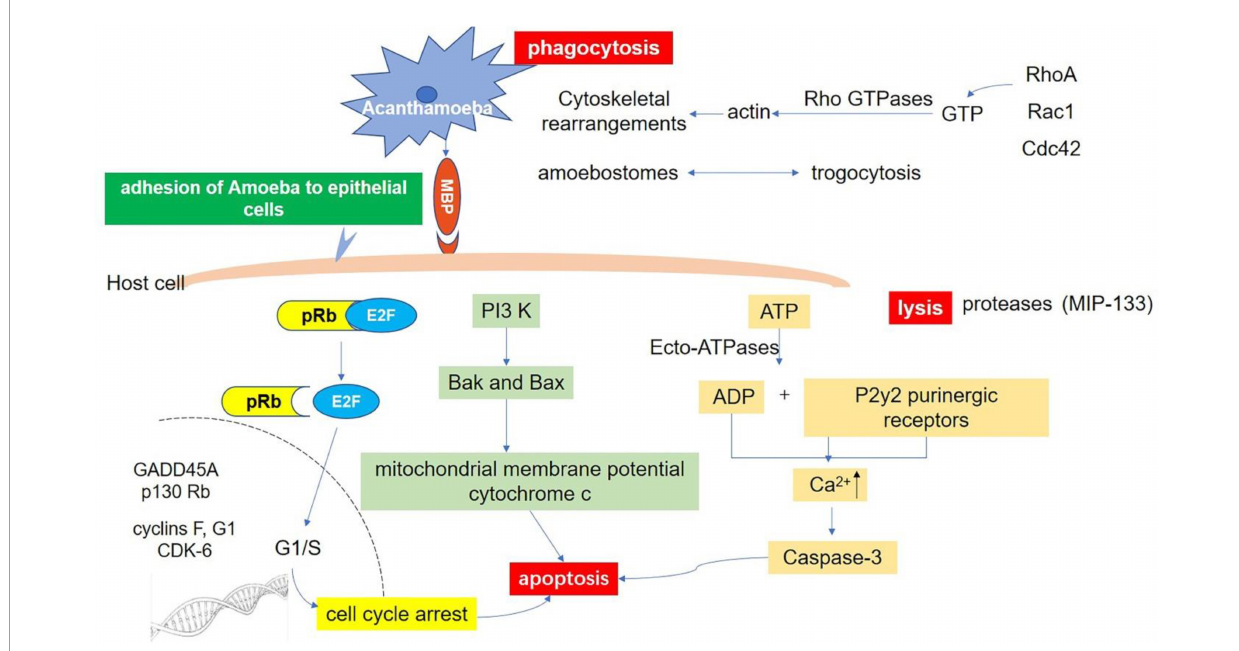
FIGURE4 Host-Parasite interaction molecular signaling pathways. Adhesion through spinous pseudopodia and adhesin (such as MBP) is the basis for Acanthamoeba to establish infection. Once adhesion is completed, the intracellular signal transduction process is activated and further triggers cascade effects such as phagocytosis of target cells, secretion of protease, and apoptosis, resulting in direct pathological damage. Phagocytosis: There are three fully studied pathways involved in this process. The RhoA pathway, which leads to stress fiber formation; Rac1 activation, which triggers plate foot formation; and Cdc42 activation, which promotes filamentous foot formation. Apoptosis: There are at least three pathways related to apoptosis after infection of Acanthamoeba . Ecto-ATPases driven cell apoptosis; Interference with the expression of important genes that regulate cell cycle; and the phosphatidylinositol 3-kinase (PI3K) mediated apoptosis pathway. Lysis: Acanthamoeba secretes a variety of proteases involved in cell lysis. A serine protease (MIP133) has been identified as a key component in the pathogenesis of Acanthamoeba